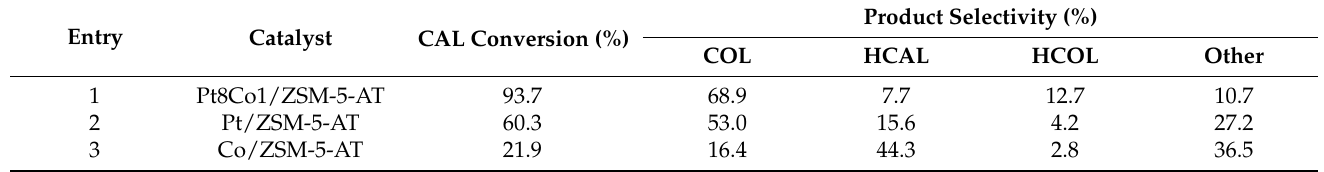
Table 2. The catalytic results for the liquid-phase selective hydrogenation of CAL over the Pt8Co1/ZSM-5-AT, Pt/ZSM-5-AT and Co/ZSM-5-AT catalysts.